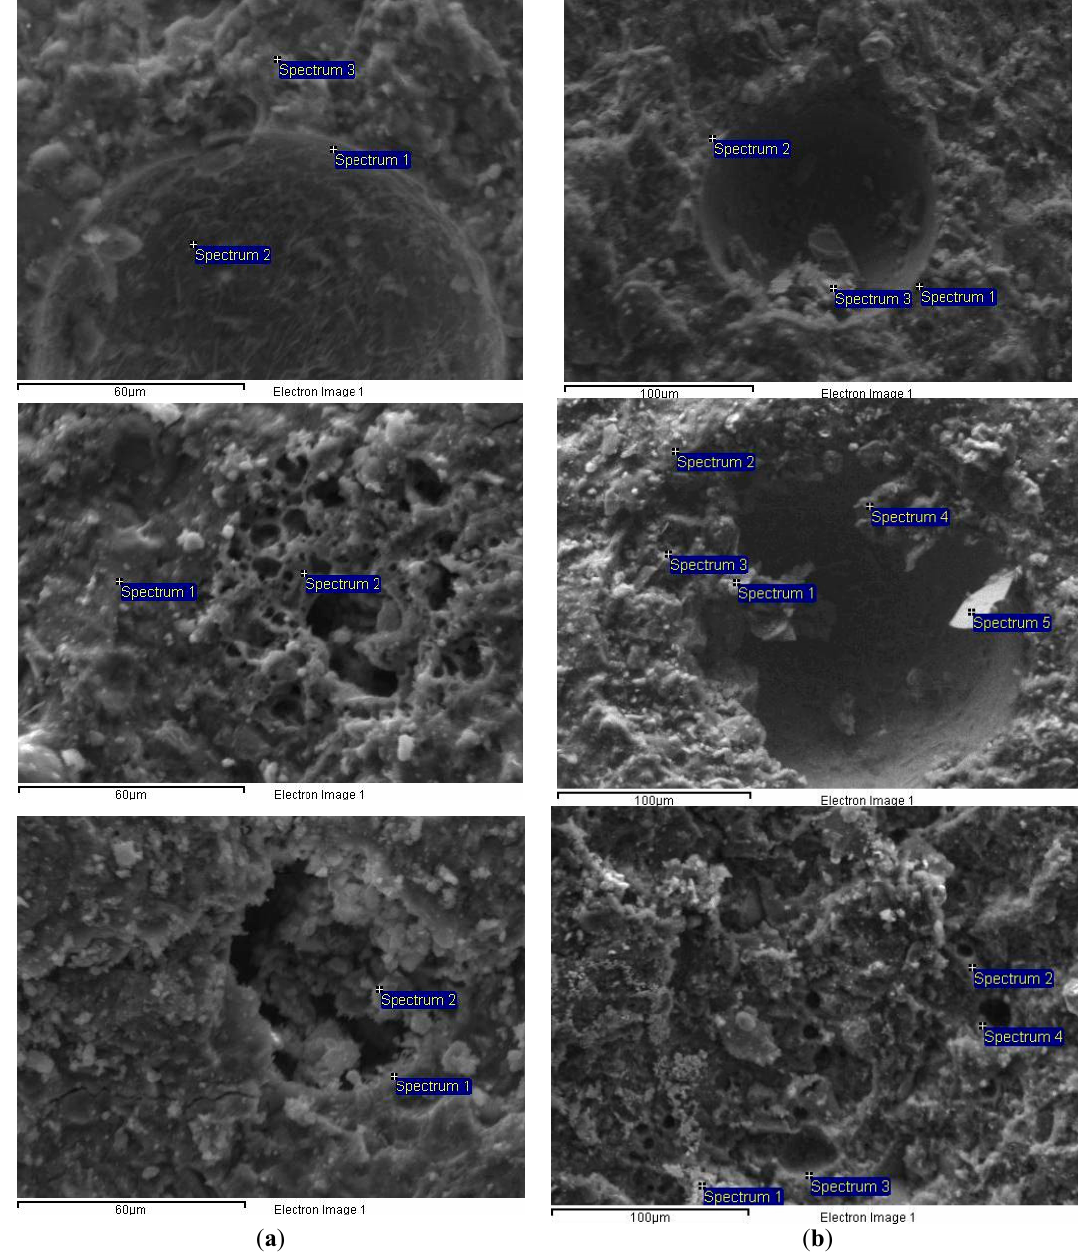
Figure 6. SEM-micrographs of samples cured; ( a ) in water immersion and; ( b ) under wetting- drying cycles, at 28 days. Table 5. EDS analysis of the micrographs shown in Figure 6.